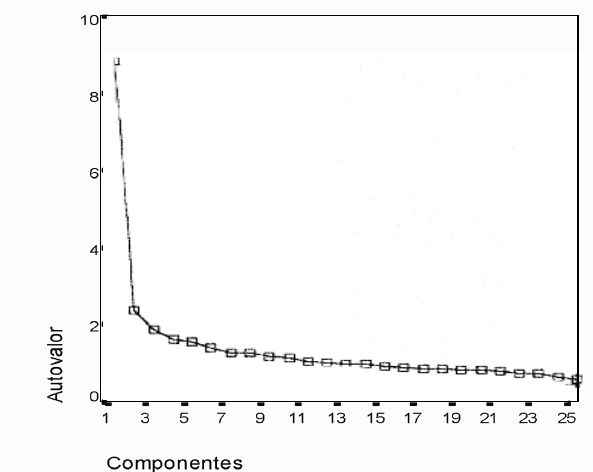
anÆlise dos componentes principais realizada com os 25 itens da